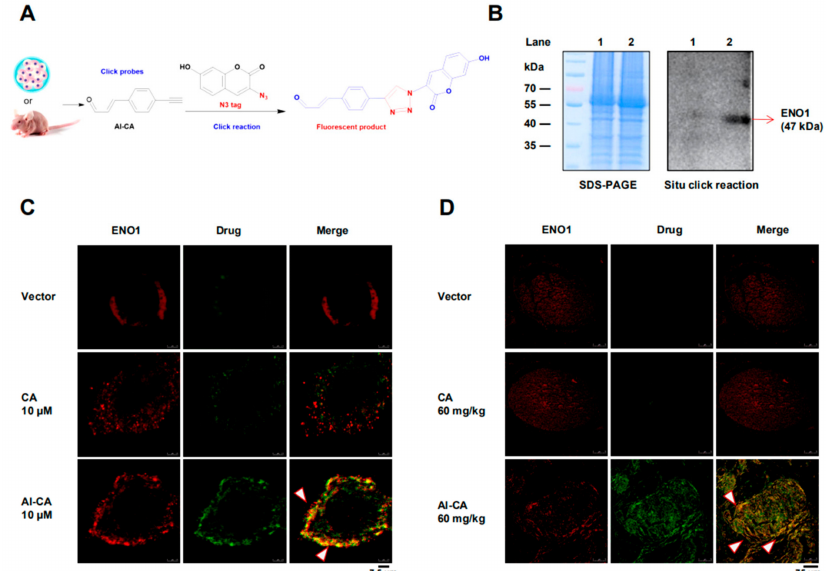
Figure 3. CA colocalized with ENO1 both in vitro and in vivo. ( A ) Schematic diagram of fluorescent click reaction of the Al-CA probe with the N3-tag. ( B ) In situ click reaction on PVDF membrane. After SDS-PAGE was performed, the click reaction was performed with an N3-tag in situ. Lane 1 shows the A375 lysate treated with CA as a loading control; and Lane 2 shows the A375 lysate treated with an AL-CA probe. All of the protein samples were adjusted to equal amounts before capture. ( C ) The colocalization imaging of the Al-CA probe and the ENO1 protein on A375 cells with fluorescence confocal microscopy. ( D ) In vivo imaging for CA and ENO1. A375 cells were subcutaneously injected into the nude mice. When the tumors formed for one week, mice were treated with CA (60 mg / kg / day) or Al-CA (60 mg / kg / day) for two weeks. Moreover, the tumor tissues were stripped to the pathological section for the colocalization imaging assay. The pseudo red color represents ENO1, which was stained by Alexa Fluor 594, and the Al-CA probe took on a pseudo green color via the click reaction. The yellow merger, where the arrow pointed, represents ENO1 colocalized with